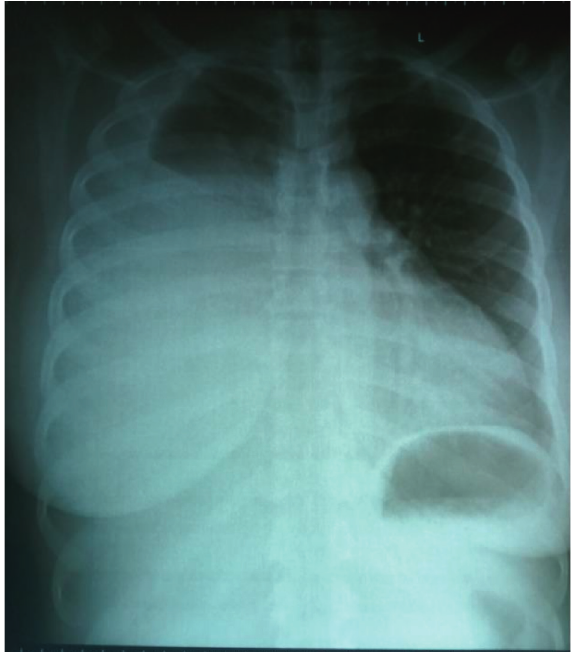
Figure 1: A plain chest radiograph of the study subject in anterioposterior view showing massive right-sided pleural effusion.